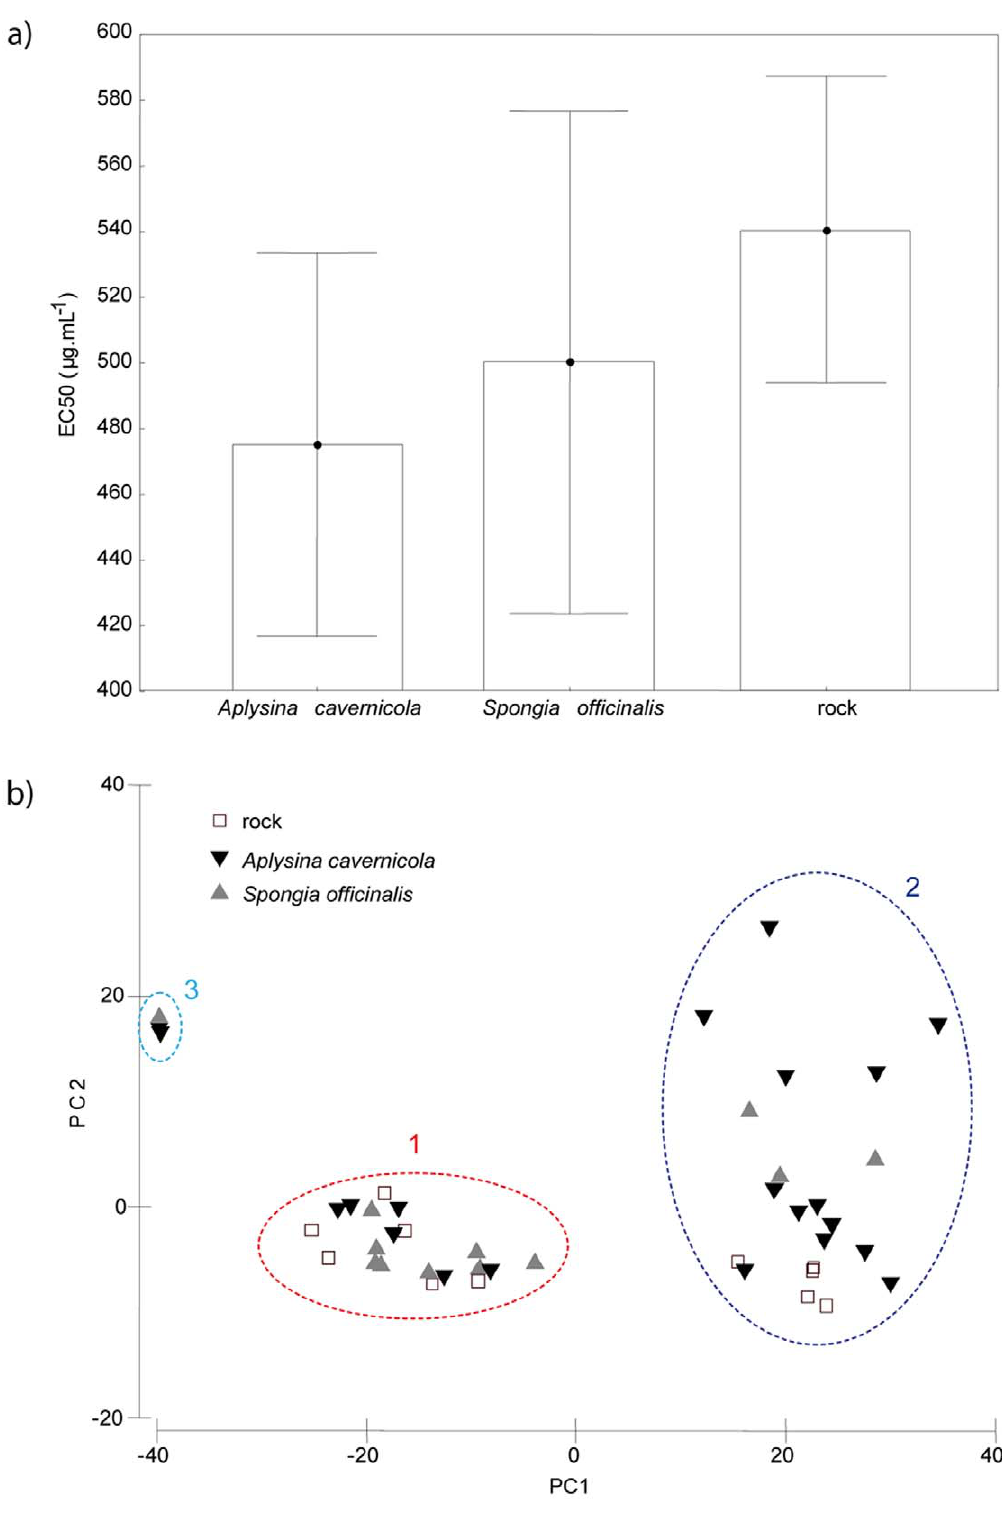
Figure 5. Influence of biotic interactions on Oscarellabalibaloi bioactivity. a) Interactions with two favorite sponge species, Spongia officinalis (n=32) and Aplysina cavernicola (n=3 4) versus rocky substrate (control, n=26) were tested. Boxes represent Mean 6 0.95 SE and vertical bars Mean 6 0.95 Confidence Interval. Significant effect indicated by Kruskal-Wallis test: H KW(2;90) = 2.61, p , 0.27. b) Relationship between metabolic phenotypes and biotic interactions of Oscarella balibaloi represented by the scatterplot of the metabolic fingerprint data set. The PC1 explains 70.2% of variation and PC2 the additional 11.3%.